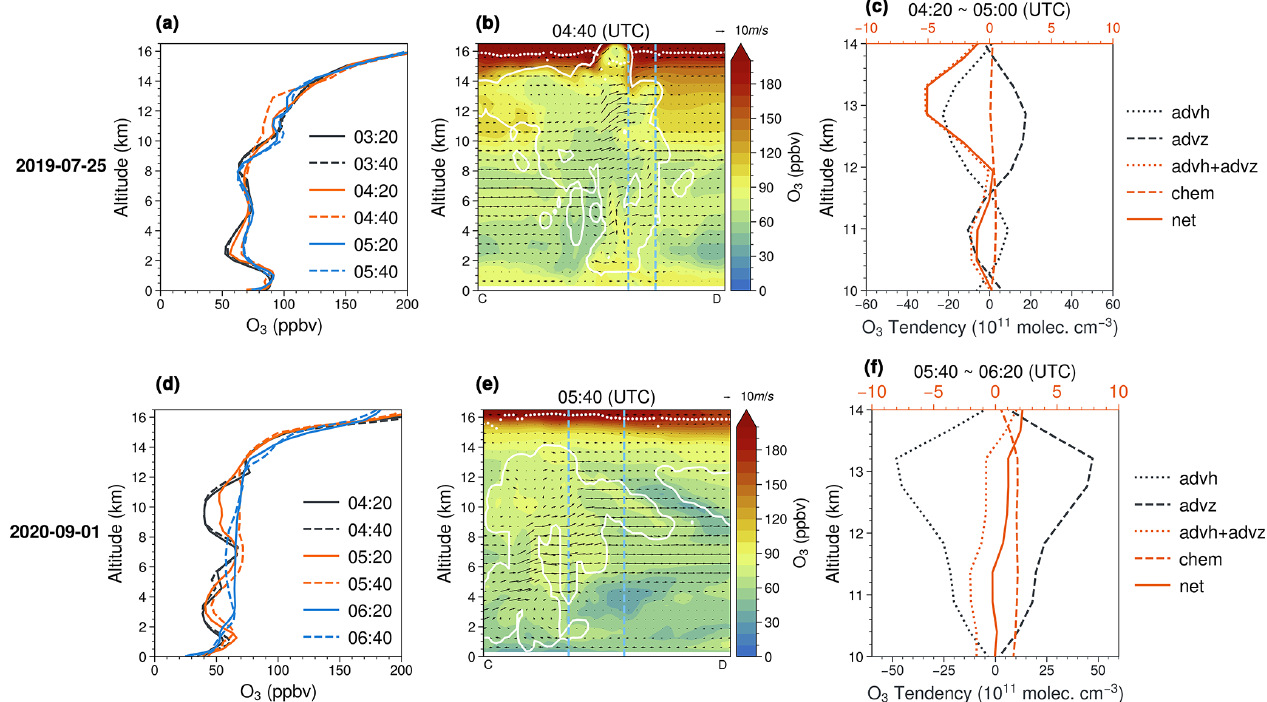
Figure 4. (a, d) The mean O 3 profiles in the regions passed by the ozonesondes at three stages: initiation (black), development (orange), and dissipation (blue). (b, e) Vertical O 3 distribution within the convective periods along the line crossing the convective core (Figs. 2e and 3f). The dashed blue lines stand for the boundaries of regions passed by the ozonesondes, and the lapse rate tropopause is shown as the white dots. The cloud boundaries (the sum of cloud liquid water mixing ratio [ q cloud ] and ice mixing ratio [ q ice ] ≥ 0.01gkg − 1 ) are shown with white lines. (c, f) The vertical distributions of the O 3 net production rate and tendency due to horizontal advection (advh), vertical advection (advz), and chemistry (chem) during the convective